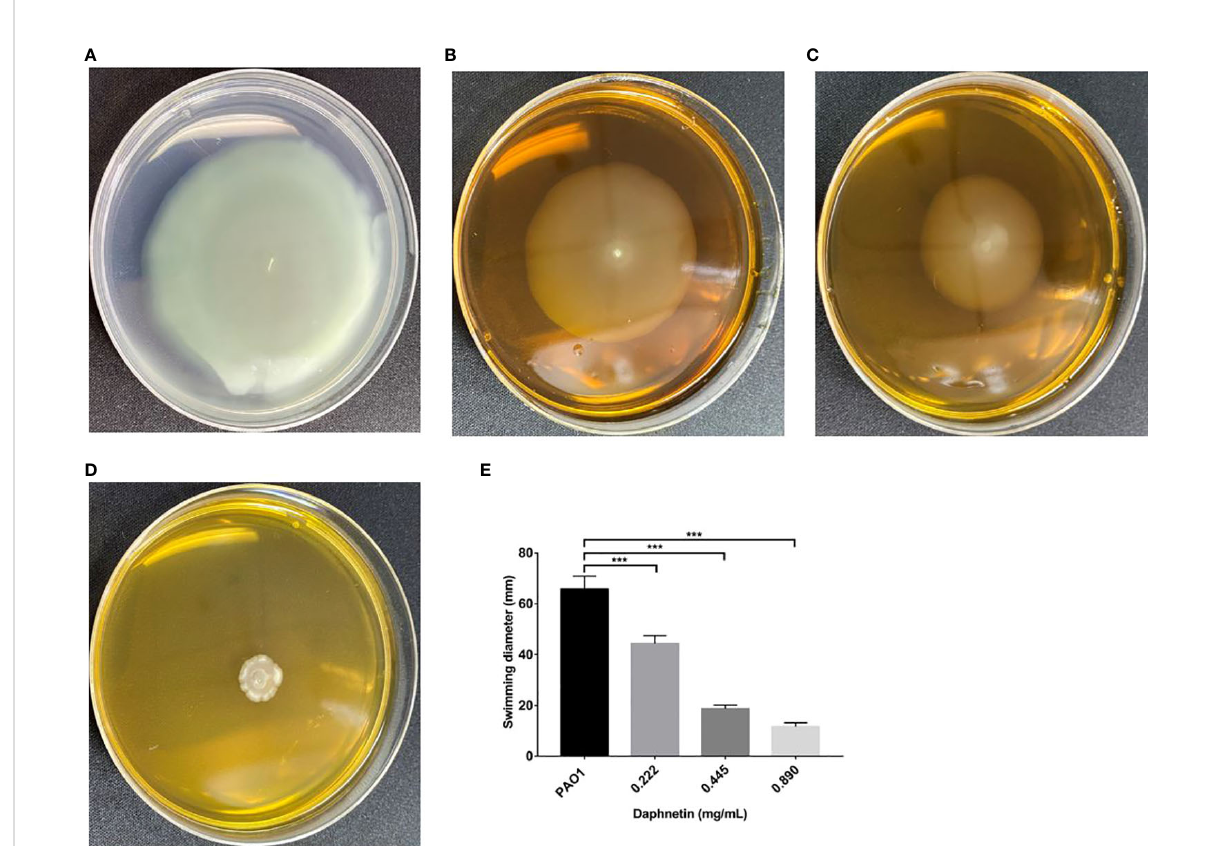
FIGURE 7 Effect of daphnetin (DAP) on swimming motility of P. aeruginosa . Swimming motility assay was conducted on plates containing different concentrations of DAP and some without DAP (Untreated Control). (A) PAO1 group. (B) DAP group with fi nal concentration of 0.222 (mg/mL). (C) DAP group with fi nal concentration of 0.445 (mg/mL). (D) DAP group with fi nal concentration of 0.890 (mg/mL). (E) Swimming diameter of each group. Results are represented as the mean ± SD; *** indicate P-values <0.001. Analysis of variance (ANOVA) test was used to compare the groups (600×600